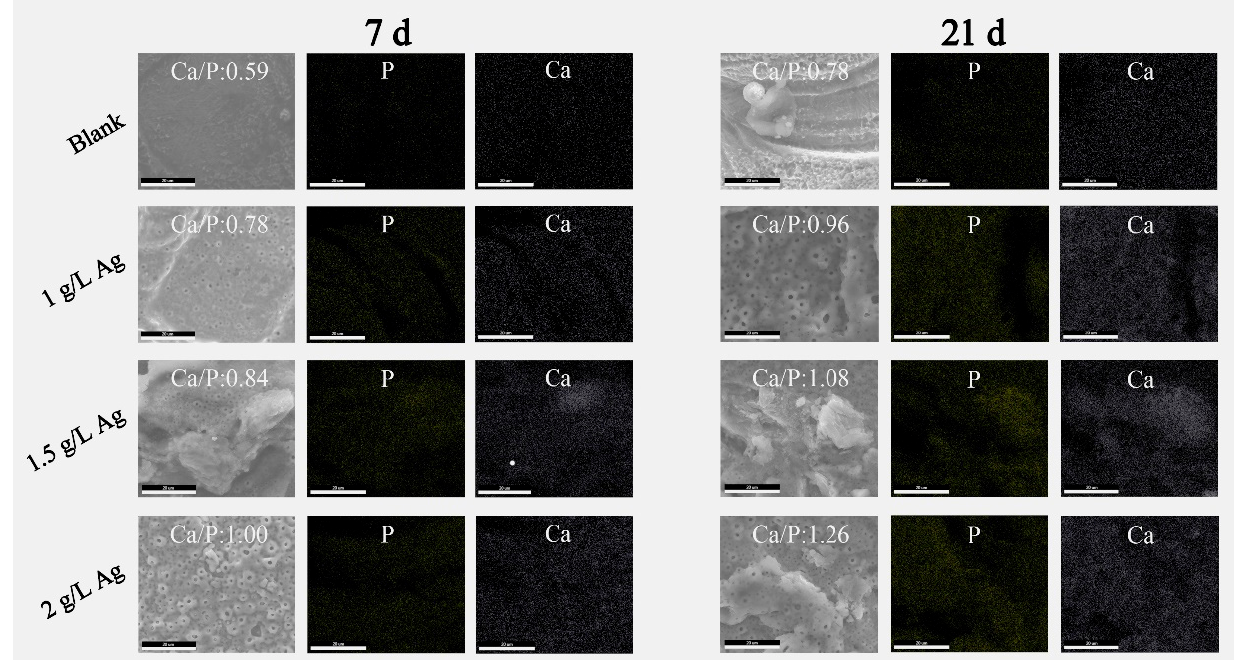
Figure 6. SEM images of the PEO-treated and untreated scaffolds immersed in SBF for 7 and 21 days.